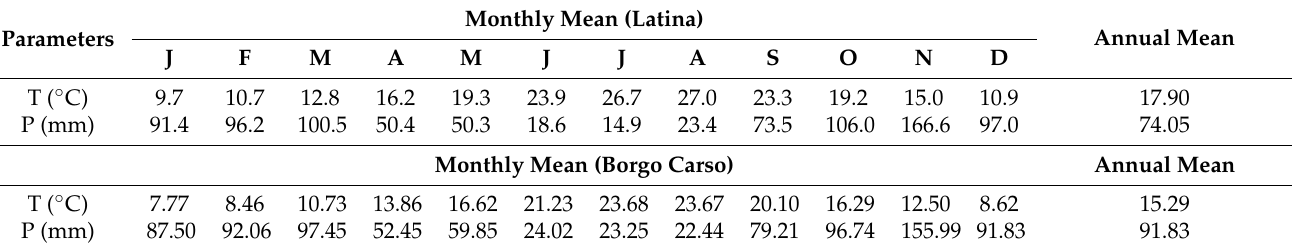
Table 1. The monthly cumulative precipitation (P) and the monthly temperature (T) in Latina and B. Carso (2010–2020).